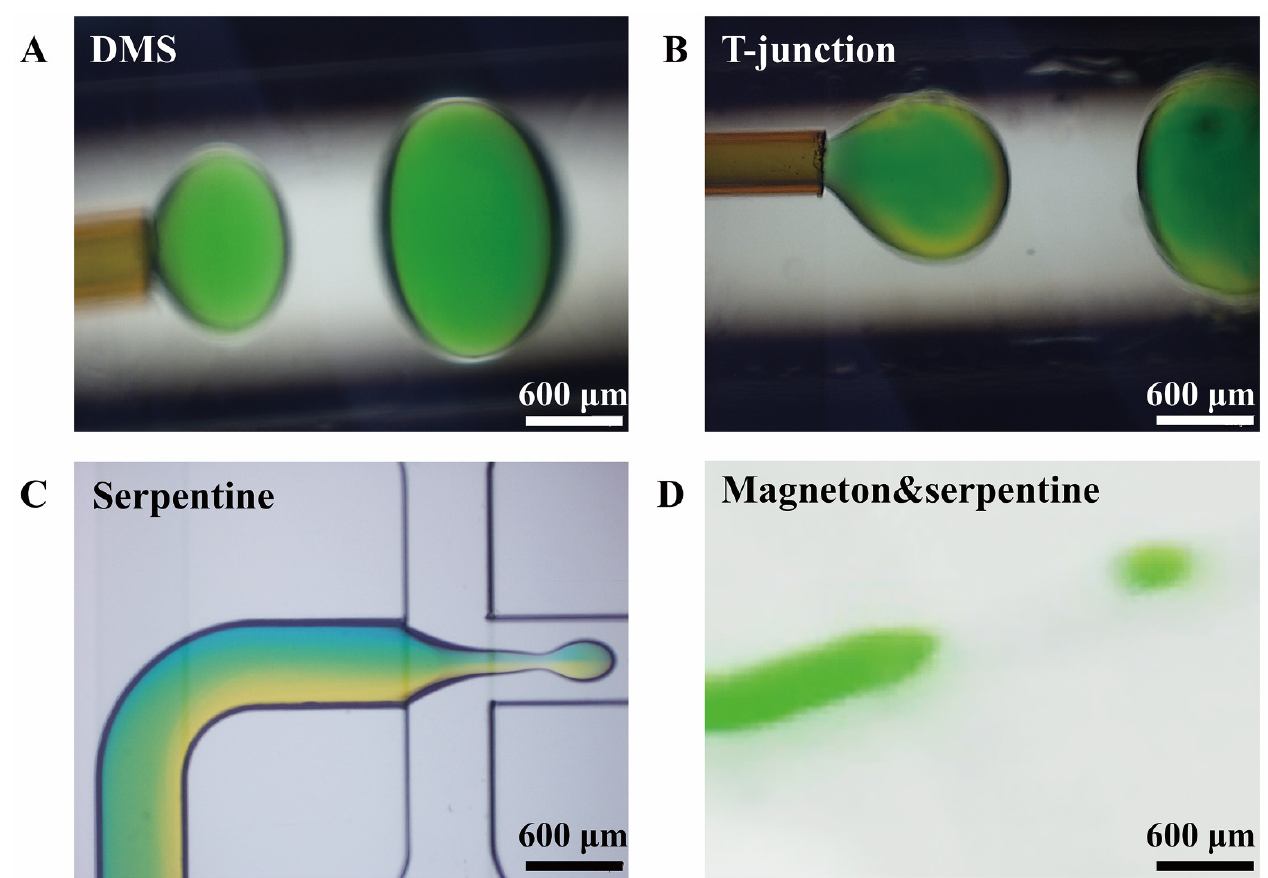
Figure 7. ( A ) DMS. ( B ) T-junction microfluidic device. ( C ) Serpentine micromixing chip. ( D ) Magneton and serpentine microfluidic